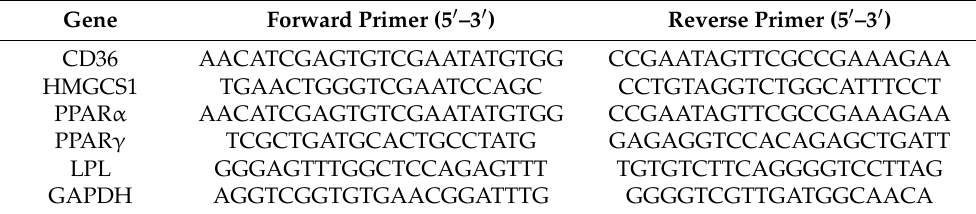
Table 3. Primer sequences for quantitative real-time PCR.